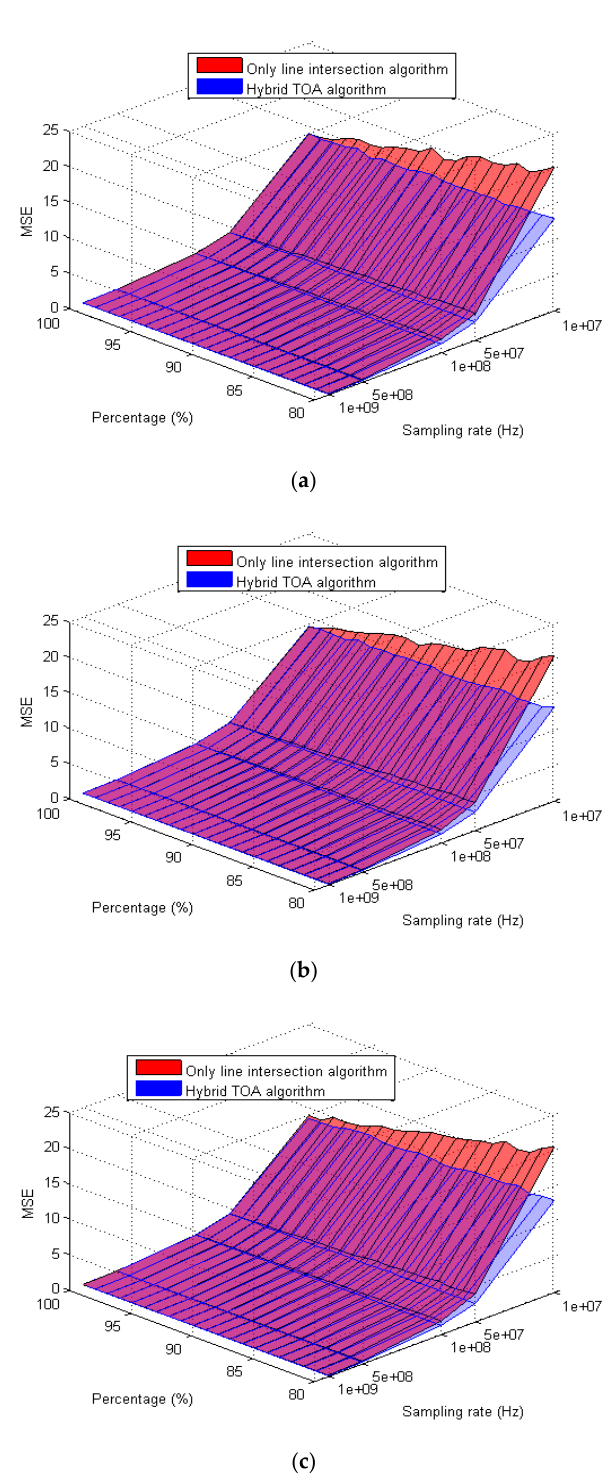
Figure 12. MSE curves for the estimated MS locations based on the hybrid TOA algorithm and only line intersection algorithm, for ( a ) the first case, ( b ) the second case, and ( c ) the third case, for the first set.